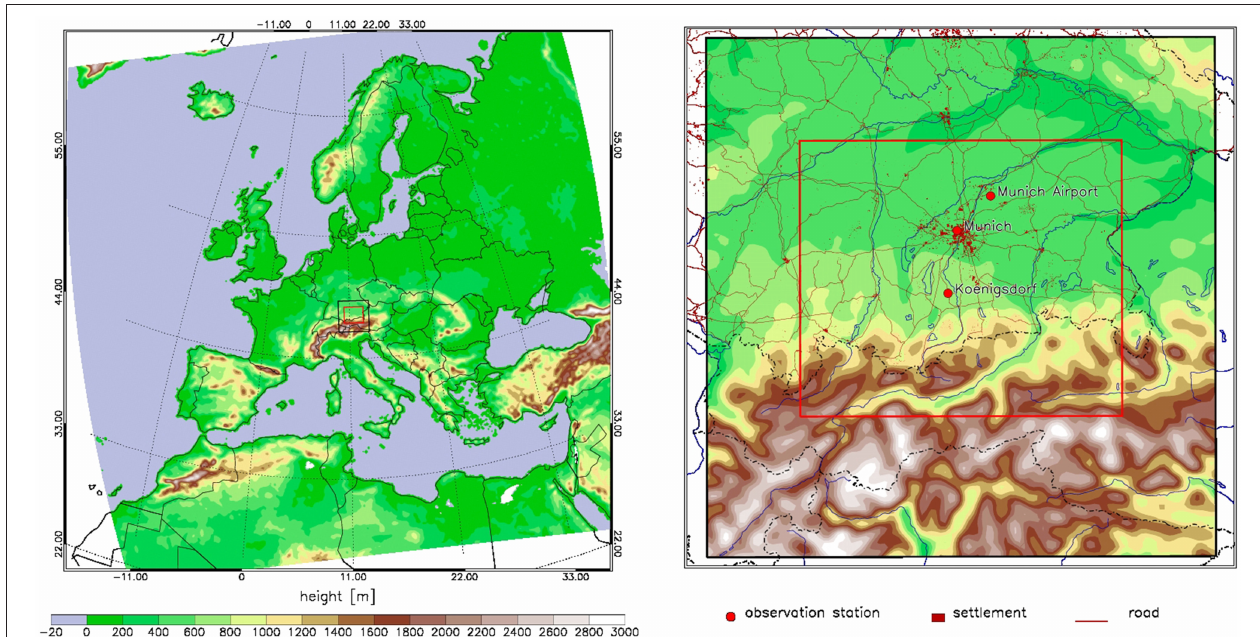
FIGURE 3 | Model domains for EUROPE (left) and for MUNICH (right) nested into the Europe domain (location of the nest is shown by the black frame). The domain for the analysis of model results is shown by the red frame.